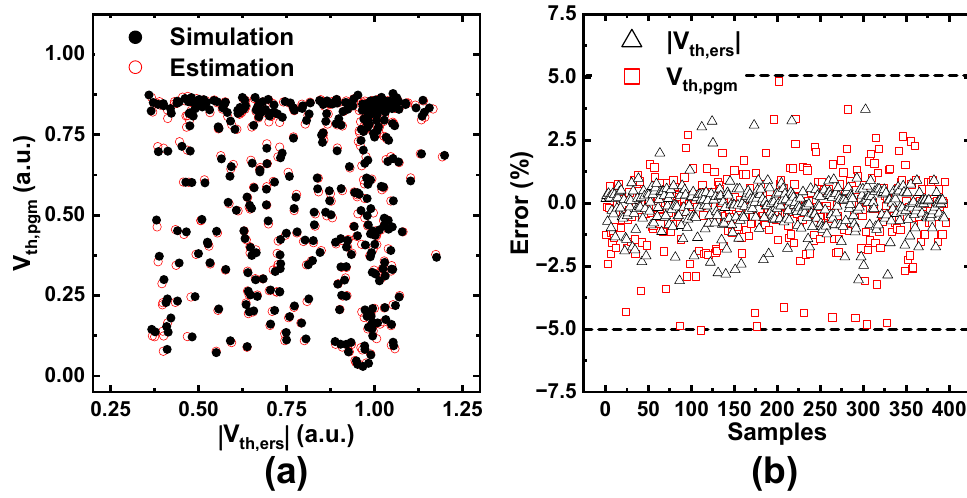
Figure 6. ( a ) Comparisons of |V th,ers | and V th,pgm between simulated (closed, black) and estimated (open, red) data, and ( b ) errors are within ±5% in the test sets. MSEs are 0.7368 × 10 − 3 and 0.8472 × 10 − 3 , respectively.